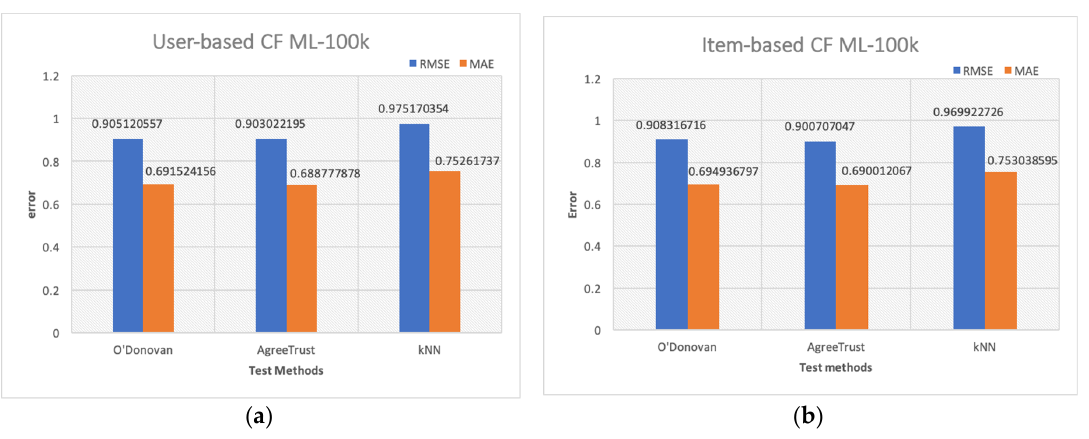
Figure 2. Result of the three CF methods for the Jester dataset: ( a ) user-based and ( b ) item-based.